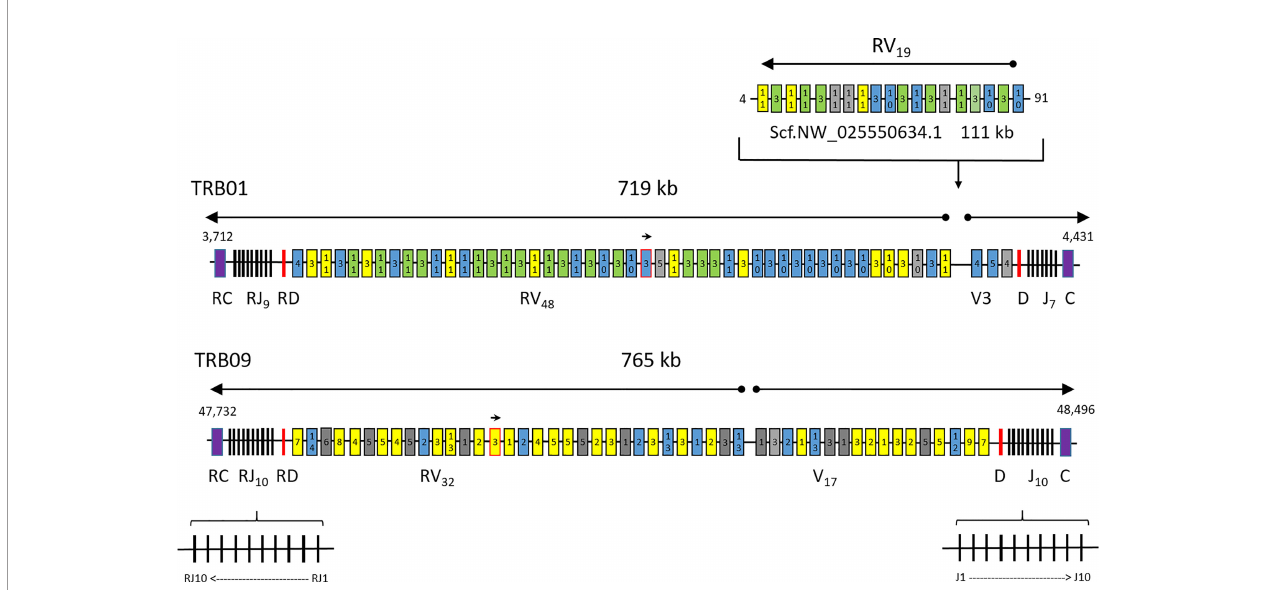
FIGURE 1 | Atlantic salmon TRB chromosomal regions. Schematic overview of the T cell receptor beta loci present on chr.01, chr.09 and the unplaced scaffold with regional positions shown on each side. The regions of 719, 765 and 111 kb are not draw to scale. Constant genes (C) are shown as purple boxes, joining genes (J) as black lines, diversity genes (D) as red lines, variable genes (V) with expressed support as yellow boxes, variable genes with internal stop codons as grey boxes and bona fi de variable genes without expressed support as blue boxes. Expressed sequences with complete identity to several variable genes are shown as green boxes. Variable gene subgroup is shown with numbers inside each box. The unplaced scaffold belongs in the chr.01 region, but may or may not represent another haplotype. A small arrow shows the TRBV gene in opposite orientation of transcription in the locus on both chromosomes while large arrows above the regions show transcriptional direction. The orientation of individual joining genes is only shown for the TRB09 region, but the same principle also applies for joining genes on